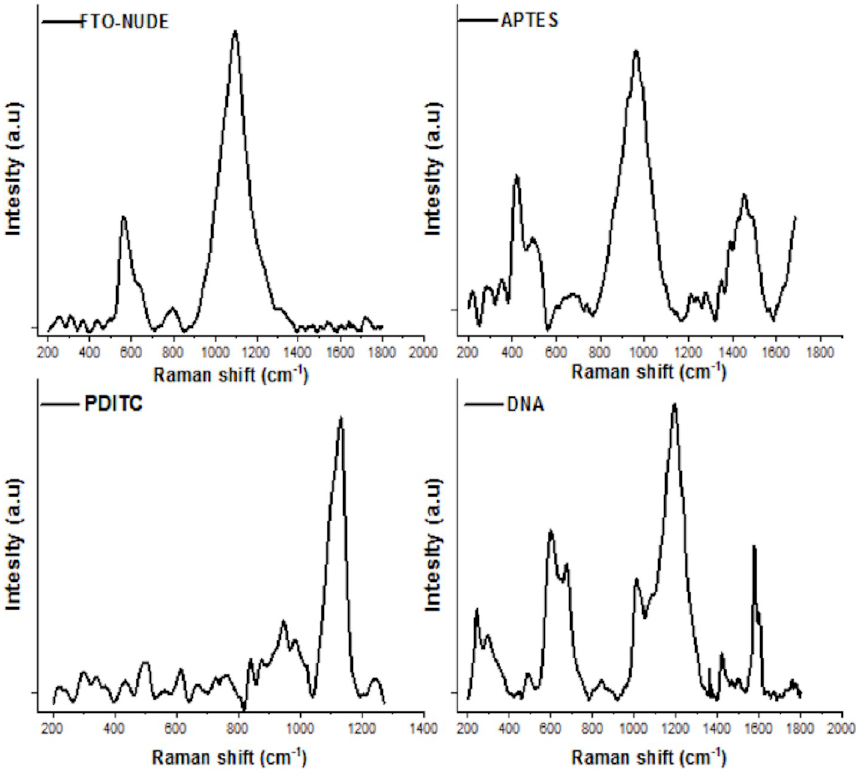
Fig 2. Raman shift of interaction with each monolayer; FTO-nude, this the first step for modification of the sensor, followed by monolayers of APTES, PDITC and DNA, showing an interaction between them demonstrating adequate